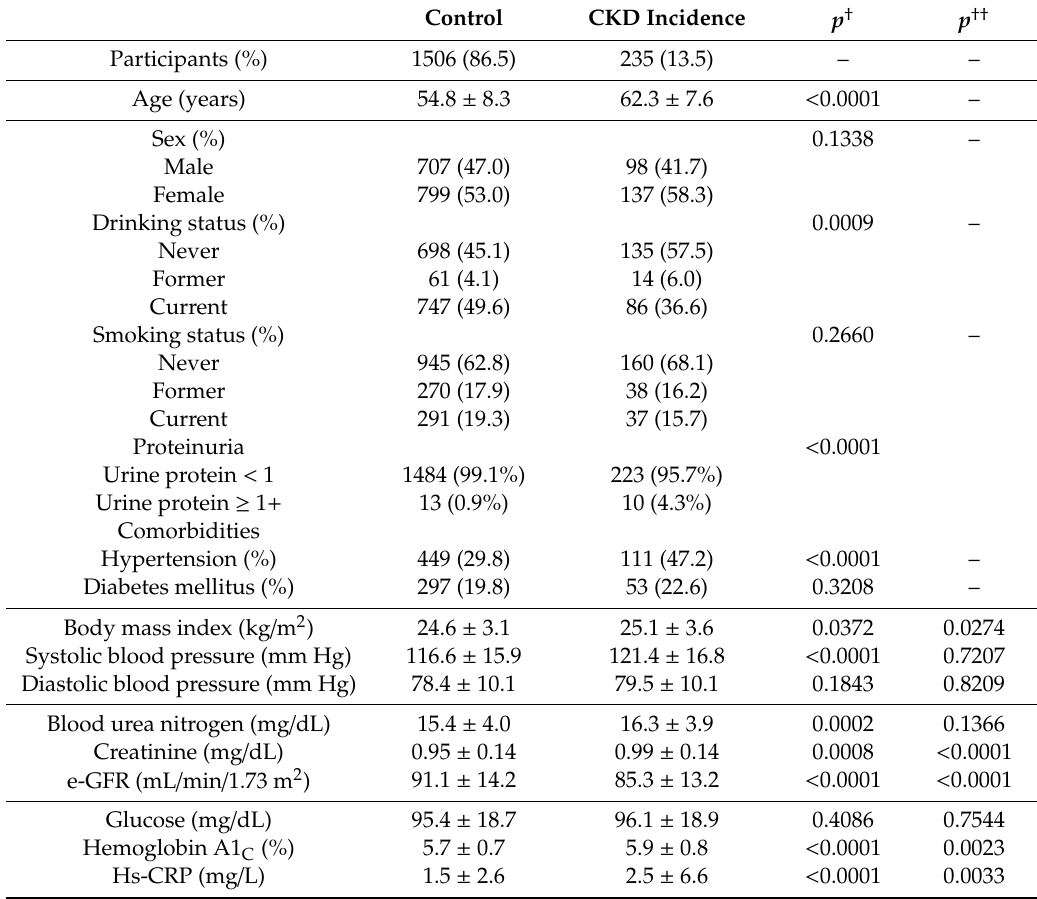
Table 4. Baseline characteristics of subjects with and without CKD after eight